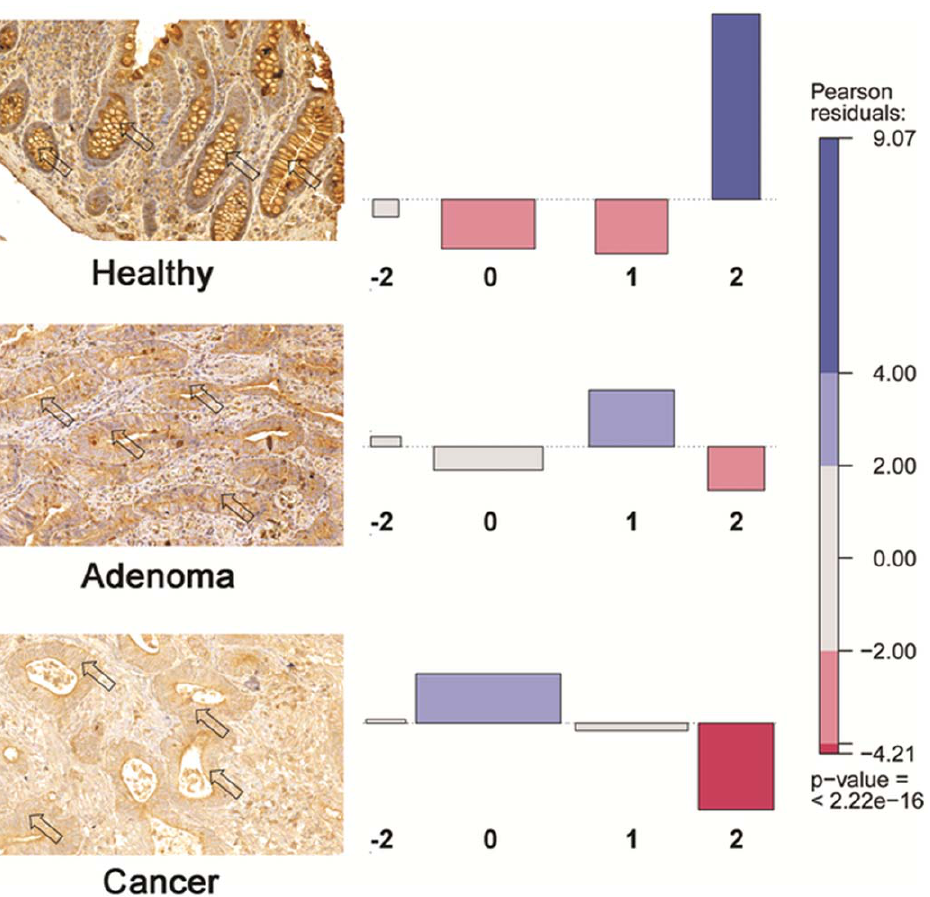
Figure 6. Immunhistochemical staining (20 6 magnification) of the prostaglandin D2 receptor (PTGDR) protein (left panel) on normal colon (top), adenoma (middle) and tumorous (bottom) colonic tissues illustrating the progressive decrease of the intraepithelial PTGDR protein expression (arrows) in the adenoma-carcinoma sequence. In the normal samples (top), predominantly strong, diffuse cytoplasmic staining was detected, which moderately decreased in the adenoma samples (middle), and only weak cytoplasmic staining was observed in the colorectal cancer samples (bottom). The right panel shows the association plots which represent tendentiously decreasing PTGDR protein expression along the adenoma carcinoma sequence. To measure the association of two variables (expression and disease stage), the Chi-square test was used. The height (and color depth) of the boxes is proportional to the difference between the observed and expected frequency of scores. The downward red colored boxes indicate that the observed frequency is lower than expected. The upward, blue items represent the opposite. PTGDR immunostaining scores: 2 2=no staining; 0=weak staining; 1=moderate staining; 2=strong diffuse epithelial cytoplasmic